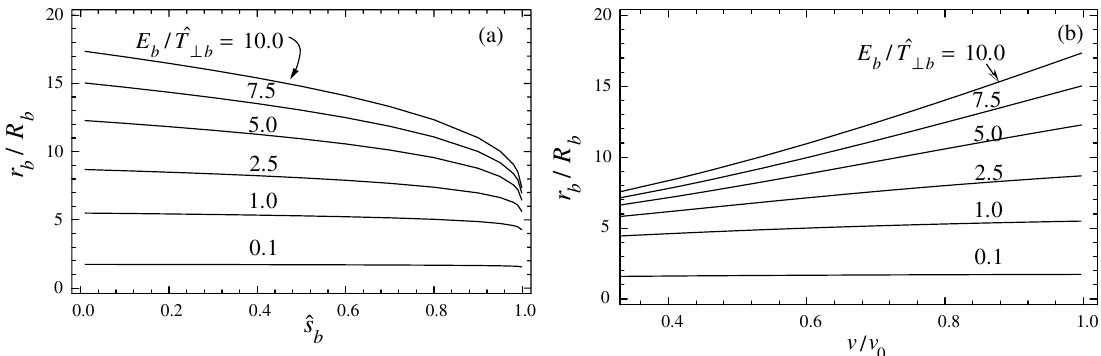
=R =R versus ^ ss and (b) r versus )=) b b b b b = ^ TT ? ranging from 0 : 1 to 10 b b